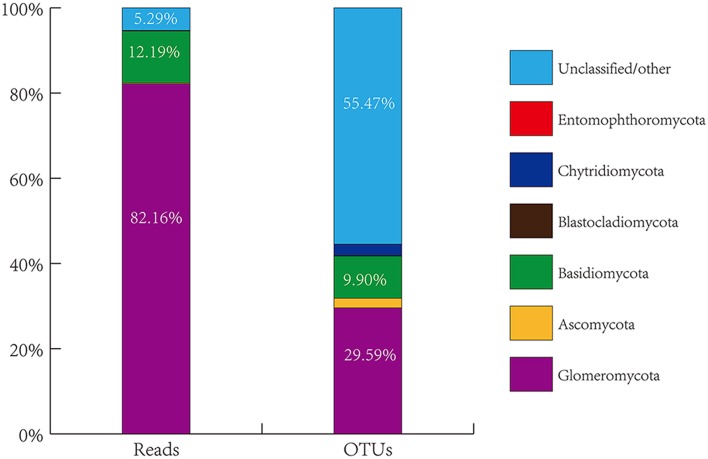
Proportional distribution of total sequence reads and generated OTUs grouped by phyla of fungi from all citrus root samples through blasting against the SILVA database.